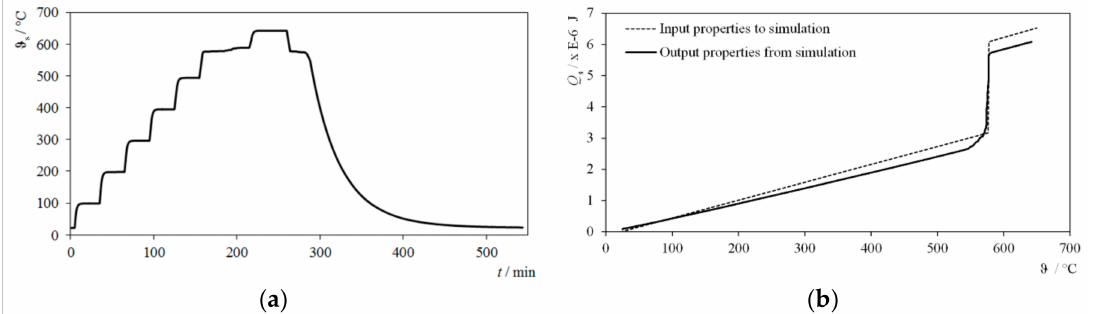
Figure 8. Results of isoperibolic procedure with cooling correlation. ( a ) Course of simulated sample temperature over time . m = 20 kg/h. ( b ) Course of Q S curve resulting from simulation (solid) compared to curve resulting with t eq = 30 min and from simulation input values